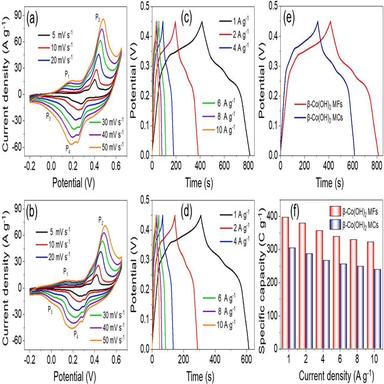
The CV profiles of (a) β-Co(OH)2 microflowers and (b) β-Co(OH)2 microclews under various scan rates, the GCD profiles of (c) β-Co(OH)2 microflowers and (d) β-Co(OH)2 microclews at different current loads, (e) the GCD profiles of β-Co(OH)2 microflowers & microclews at 1 A g− 1 , and (f) the rate performance of β-Co (OH)2 microflowers & microclews.